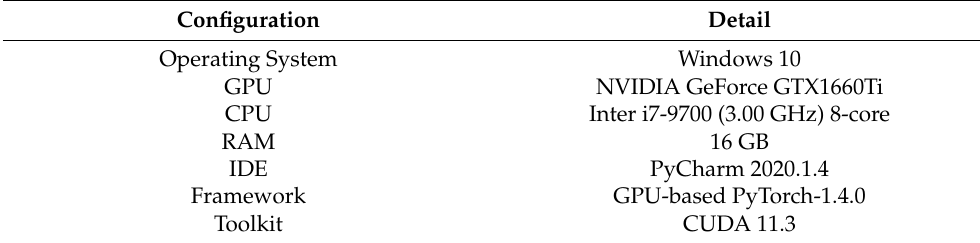
Table 1. The configuration of experimental